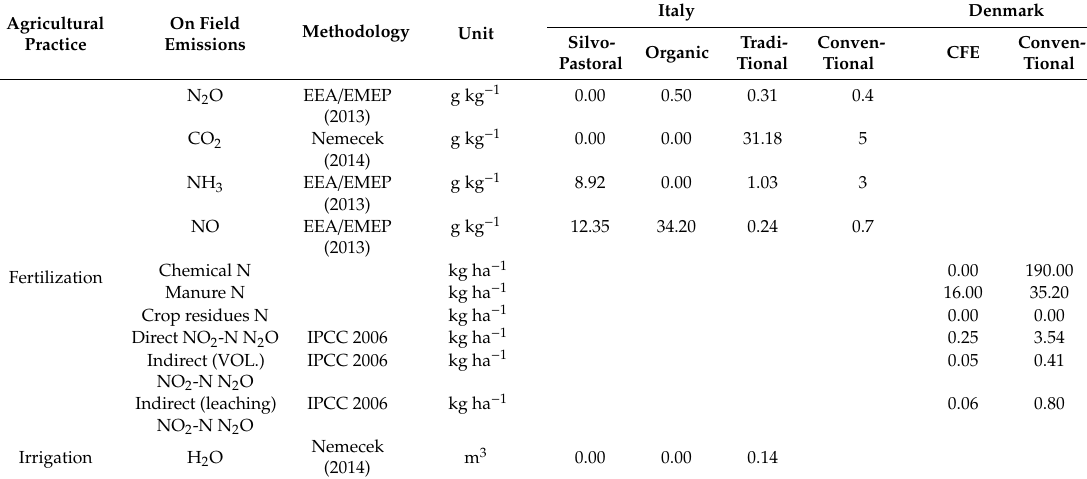
Table 1. Estimations of estimated greenhouse gas (GHG) emissions from four agroforestry systems in Italy and two production systems in Denmark. CFE: combined food and energy system. Agricultural Practice